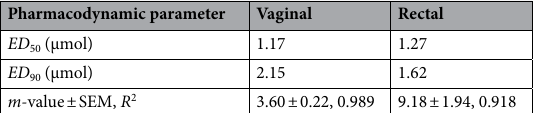
Table 4. Dose–response characteristics against HIV-1 infection of oral TAF in BLT hu-mice.